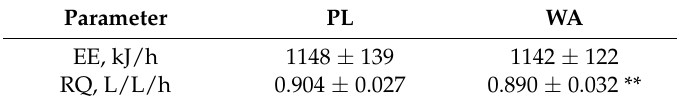
Table 3. Energy expenditure (EE) and respiratory quotient